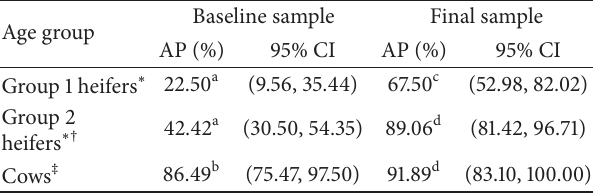
Table 2: Apparent seroprevalence and 95% CI for Anaplasma marginale at baseline and final sampling times and 𝑃 values for McNemar’s test comparing seroprevalence within groups at baseline and final sampling times for three cattle cohorts from a beef herd in California which were followed up for A. marginale